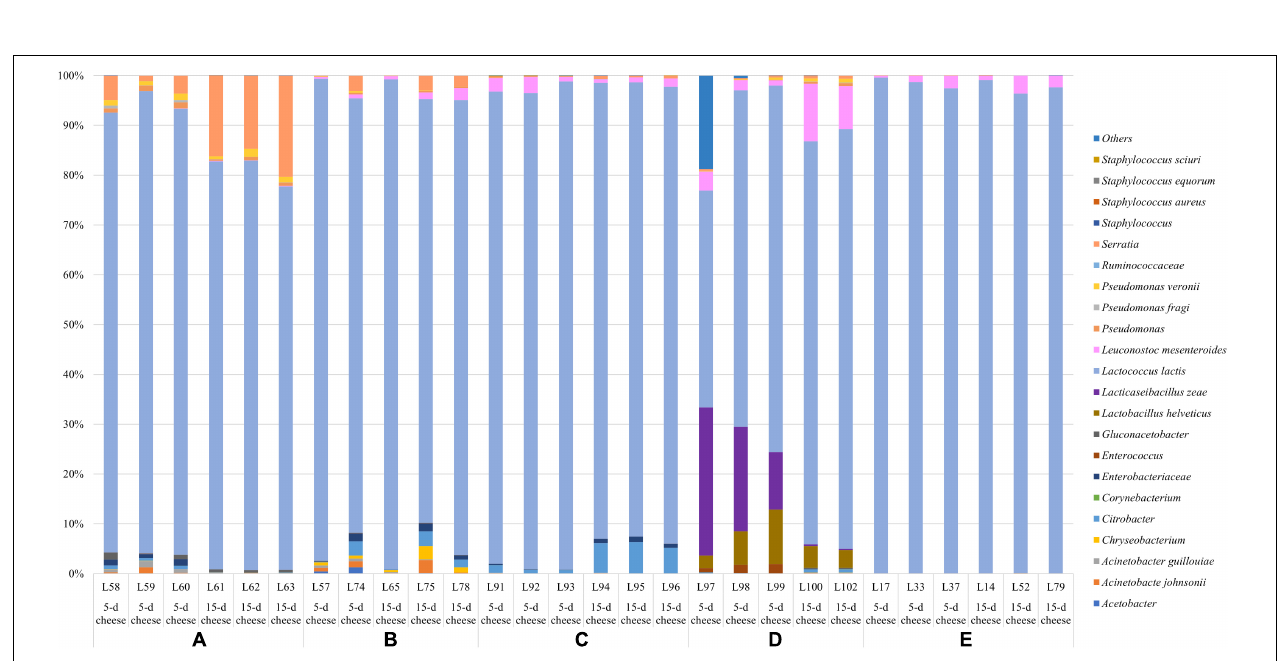
FIGURE 2 | Relative abundance (%) of the taxa detected with 16S sequencing. Only ASVs with an incidence at least 0.5% in at least two samples are shown.